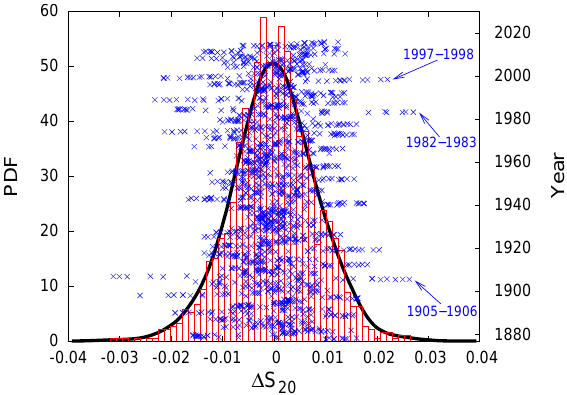
Figure 4. The PDF of (cid:49)S 20 (black curve, left scale) together with the corresponding histogram (red bars, left scale) obtained from the time series of (cid:49)S 20 , which is also plotted vs. time (blue crosses, right scale) along the vertical axis. The arrows indicate when (cid:49)S 20 exceeds 0.0205 and are labeled by the corresponding ongoing strong El Niño